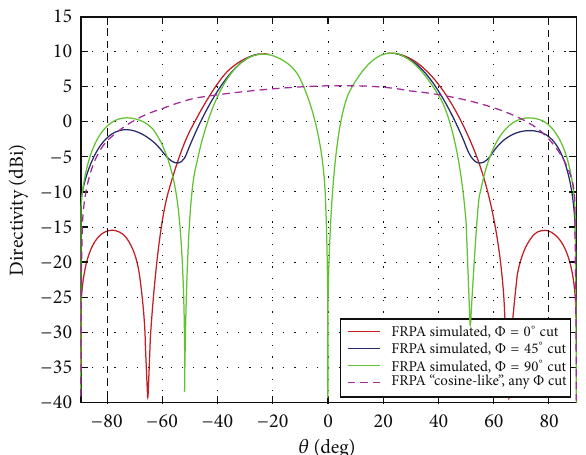
FRPA simulated, Φ = 0 ∘ cut FRPA simulated, Φ = 45 ∘ cut FRPA simulated, Φ = 90 ∘ cut FRPA “cosine-like”, any Φ cut